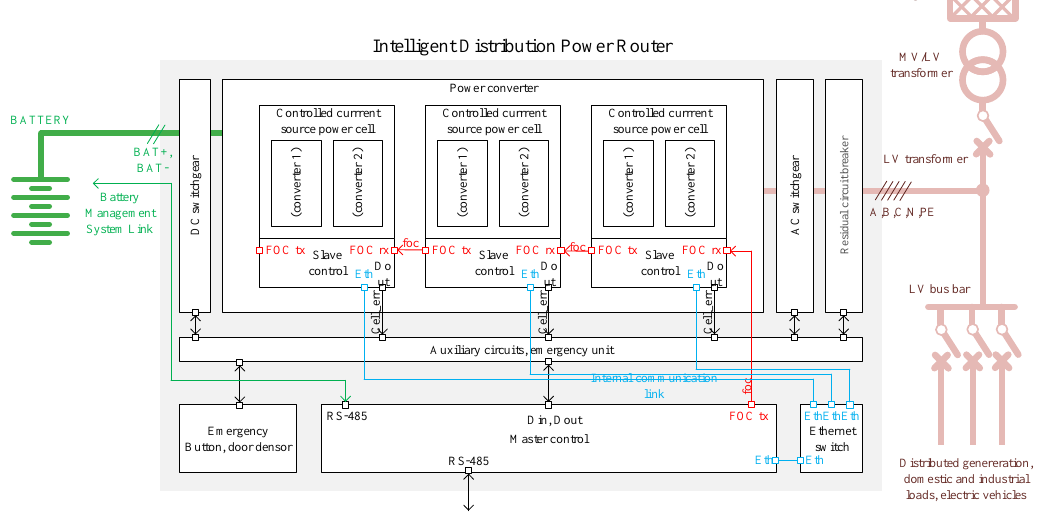
Figure 3. Architecture of an Intelligent Distribution Power Router (IDPR) with a battery